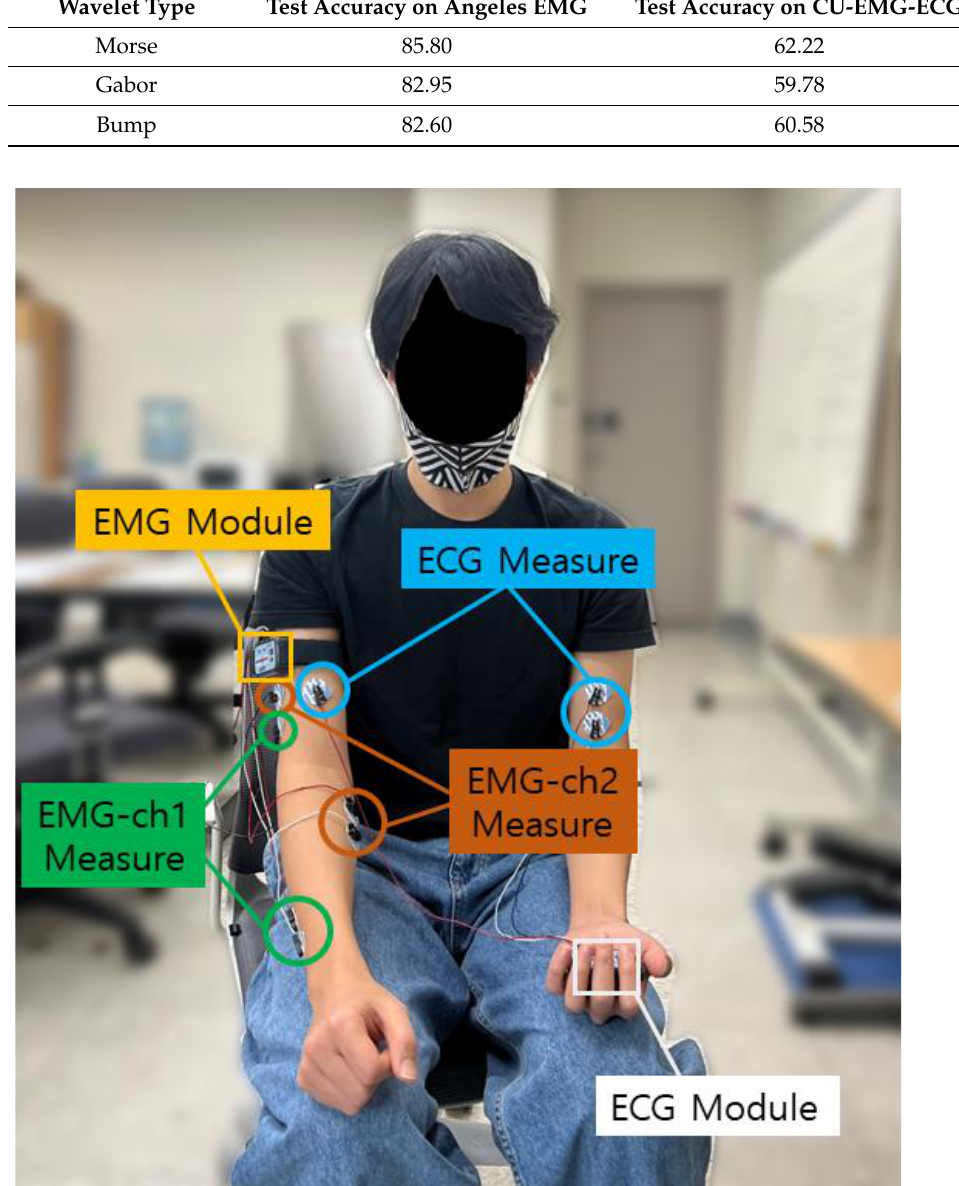
Figure 4. Environment for acquiring the CU-EMG-ECG dataset.